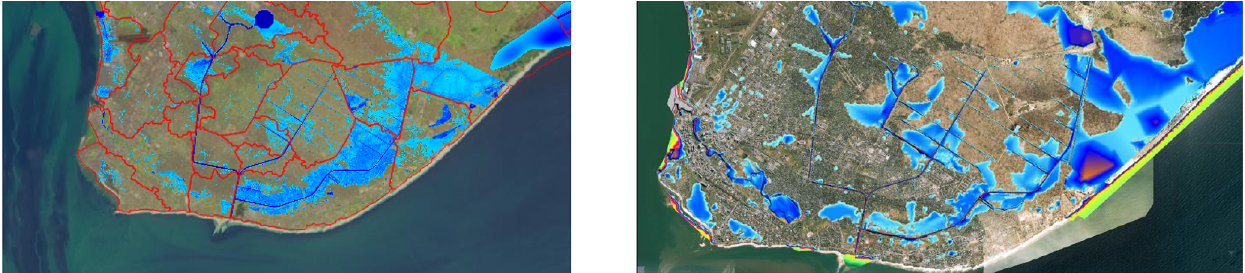
Figure 5. Flood extent resulting from a 10-year rainfall event for FLORES (left) and an ANUGA simulation, which was part of the Rio Chiveve feasibility study. Background image: Sentinel-2 (©